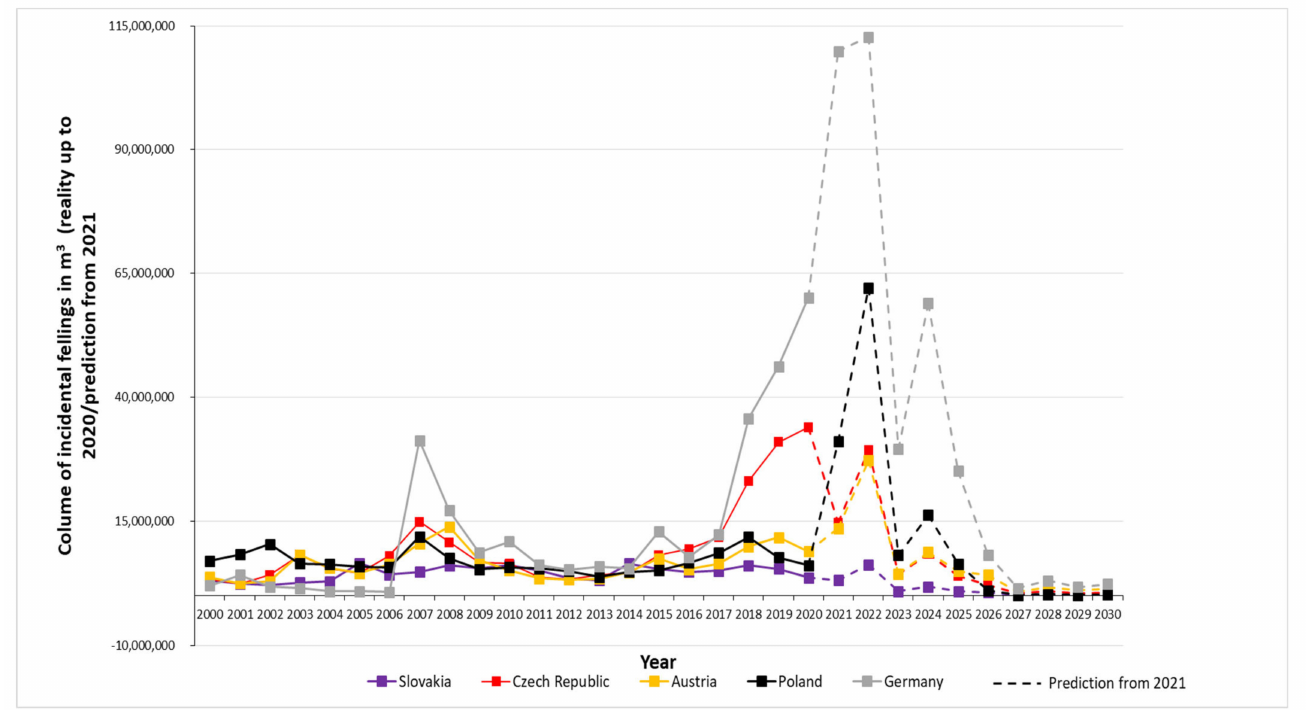
Figure 6. Volume development of Incidental fellings and SIBYLA TRIQUETRA prediction from 2021 onward in selected European countries in the time range